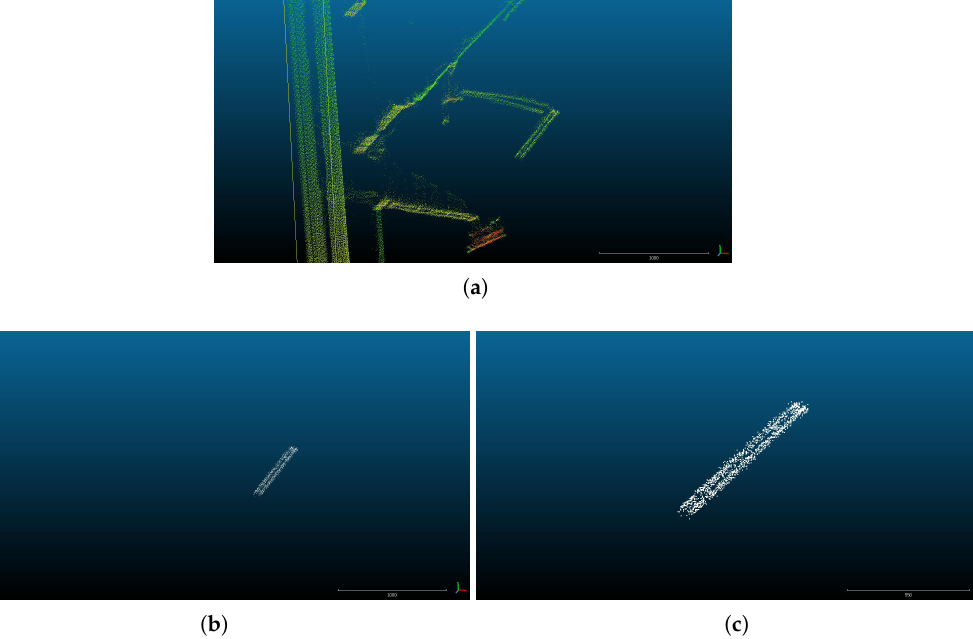
Figure 10. Point cloud recorded in a test bench environment and the points classified by the method as belonging to a wire in this point cloud. ( a ): an amplified perspective centred in the overhead contact line of the test bench environment point cloud; ( b ): points classified as contact wire by the new method; ( c ): a different perspective of the classified points.